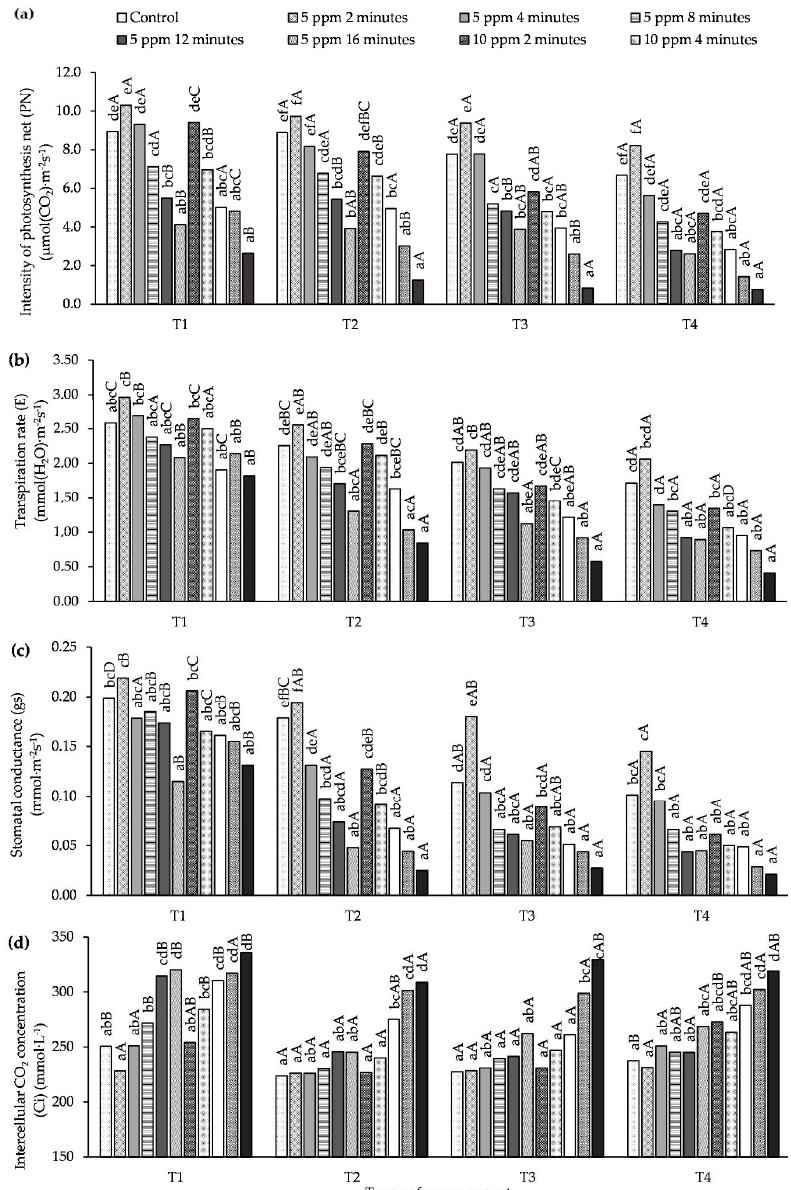
Figure 1. Changes in gas exchange parameters in potato leaves depending on O 3 concentration, exposure time and measurement terms (T1—1st day after the 1st fumigation, T2—7th day after the 1st fumigation, T3—1st day after the 2nd fumigation, T4—7th day after the 2nd fumigation). ( a ) intensity of photosynthesis net (P N ), ( b ) transpiration rate (E), ( c ) stomatal conductance (g s ), ( d ) intercellular CO 2 concentration (C i ). Lowercase letters indicate significant differences between the means at respective measurement terms, capital letters indicate significant differences between means at the measurement terms for the respective variants of O 3 concentration and exposure time ( p < 0.05).